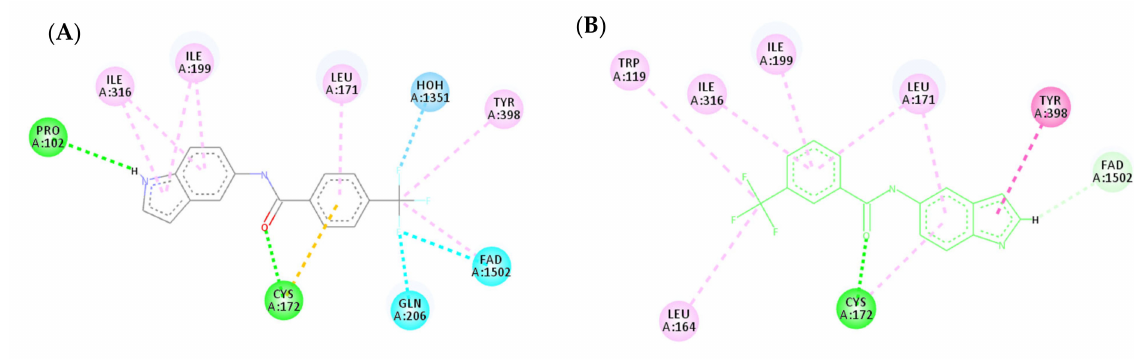
Figure 9. Two-dimensional (2D) interaction models of compounds 3v ( A ) and 3u ( B ) into the active site of